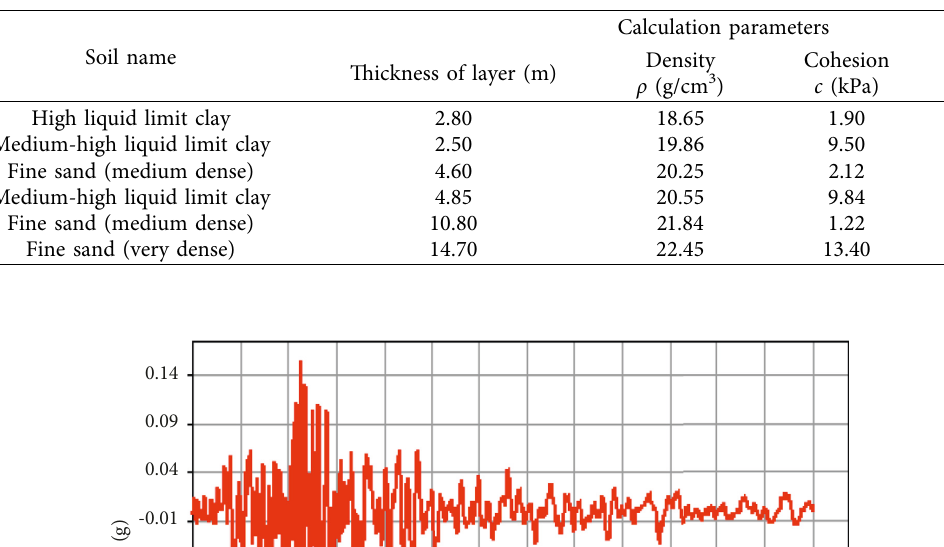
Table 1: Value of formation physical and mechanical parameters.